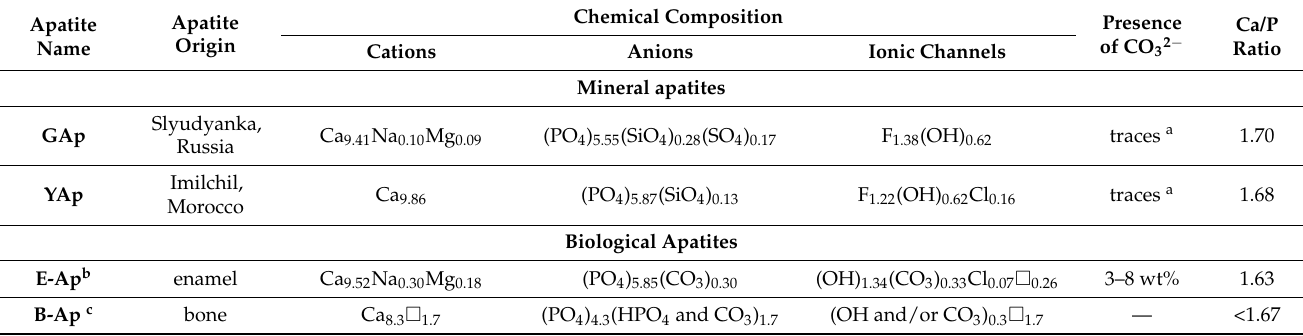
Figure A5. The structure of GAp shown as monolayers or double layers of atoms projected onto (001), (100) and (101) planes. ( a ) The double layer of atoms (of thickness Δ z = ½ c ) projected onto (001). ( b ) The same layer viewed from the side along [210]. ( c ) The double layers of atoms projected onto (101). ( d ) The side view of (101) surface projected in [010] direction. Projection onto (100) plane in slab models of A-A type layers (PO 4 -rich surface) with Ca 2+ and phosphate groups ( e ) and that of B type layer (Ca-rich surface) with F − ions and OH − groups ( g ). The side views of the layers showing sequence of A = Ca 3 (PO 4 ) 2 and B = Ca 4 (PO 4 ) 2 (F,OH) 2 for GAp (100) surfaces: ‘PO 4 -rich’ ( f ) and ‘Ca-rich’ ( h ), respectively. The layer projected on ( g ) is marked in black frame on ( h ). Color coding for atoms: calcium Ca1–dark grey, calcium Ca2–grey, oxygen–red, phosphorus–orange, fluorine–magenta and hydrogen–little black circle. Table A1. Mean chemical composition of mineral apatites GAp and YAp evaluated from SEM-EDXS measurements. The data are compared to the chemical composition of biological apatites (enamel and bone apatites) and mineral apatites originated from the same locations as GAp and